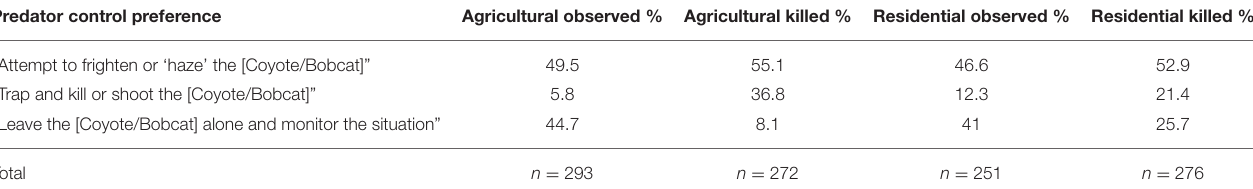
TABLE 1 | Response proportions for types of predator control preferred within each carnivore